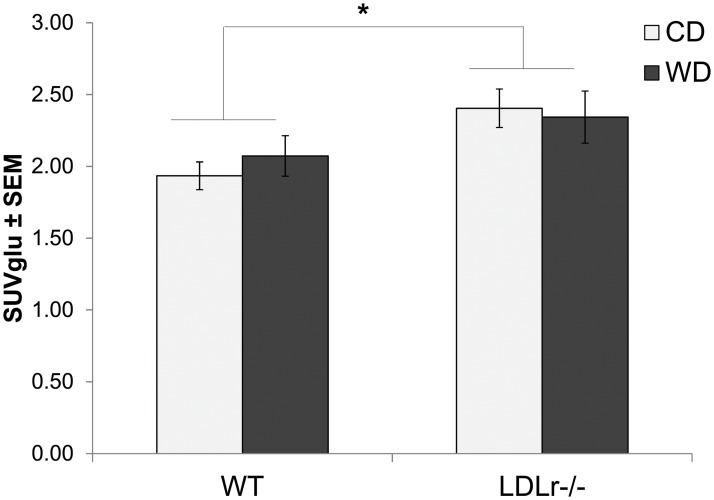
Genotype but not diet alters brain glucose uptake.18FDG uptake measured by mean standardized uptake value (SUVglu) corrected for plasma glucose from a summed static image from 20–30 min post injection of C57BL/6 (WT) or LDLr -/- mice fed control (CD) or western diet (WD). Statistical differences by two-way ANOVA between WT and LDLr -/- mice (*) p<0.05, n = at least 4/grp.